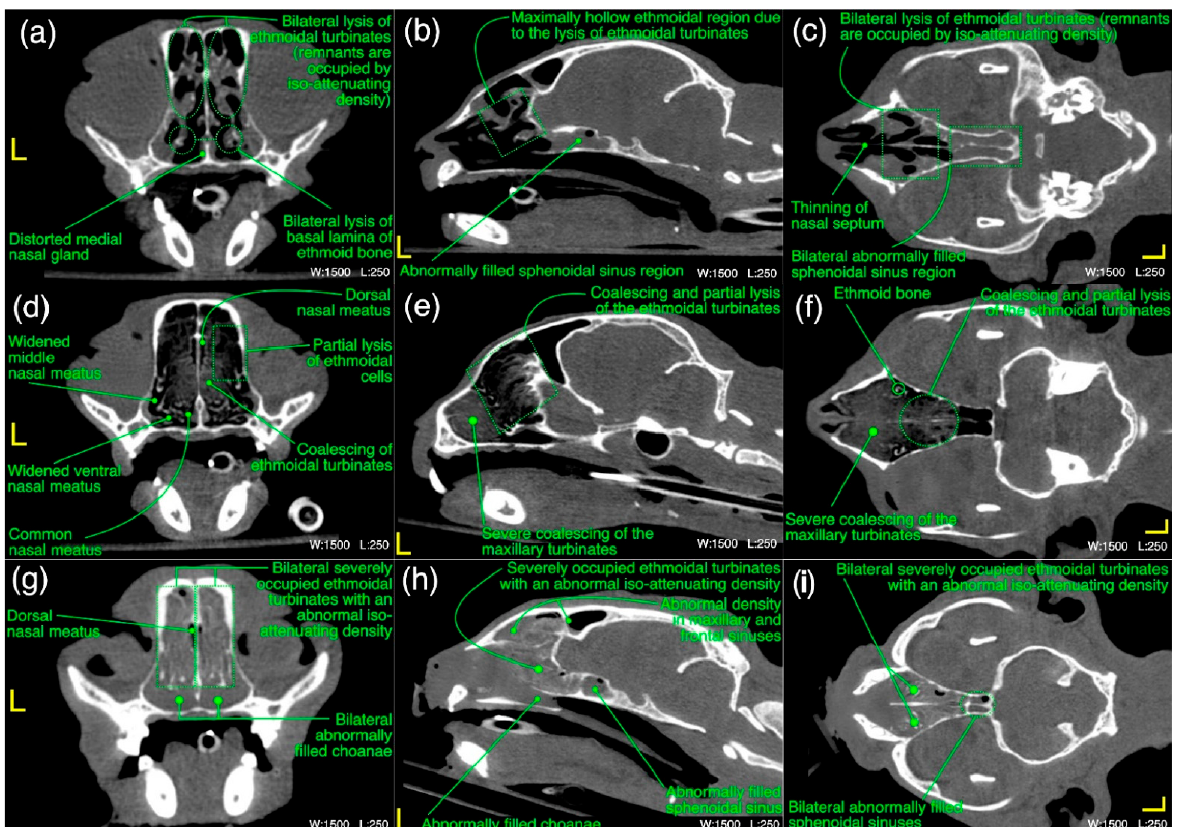
Figure 10. ( a – i ) A variety of computed tomographic changes of ethmoidal region are labeled for pathologies related to acute/chronic infectious respiratory disease signs in Cats 1, 6 and 18. Window, level and laterality are also labeled for each section.